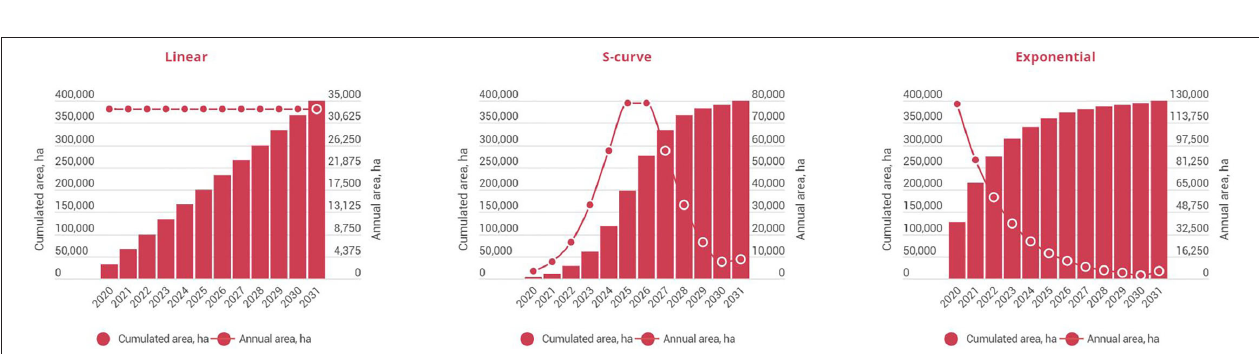
FIGURE 3 | Illustration of the dynamic of implementation of a climate action, cumulated and annual, over a period of 5 years.